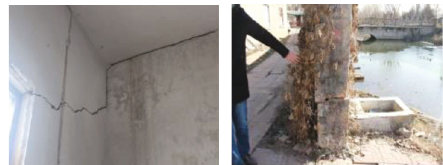
Figure 1: Crack and dislocation of fi xed brick-concrete structure pump house under coal mining